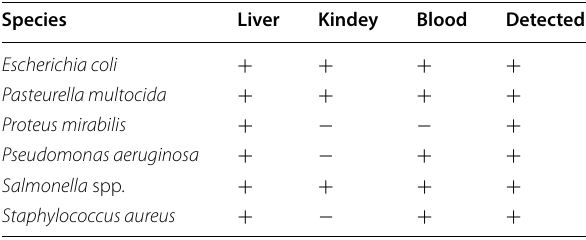
Table 4 M-PCR detection filtrates from tissues and organs after enrichment for 4 h